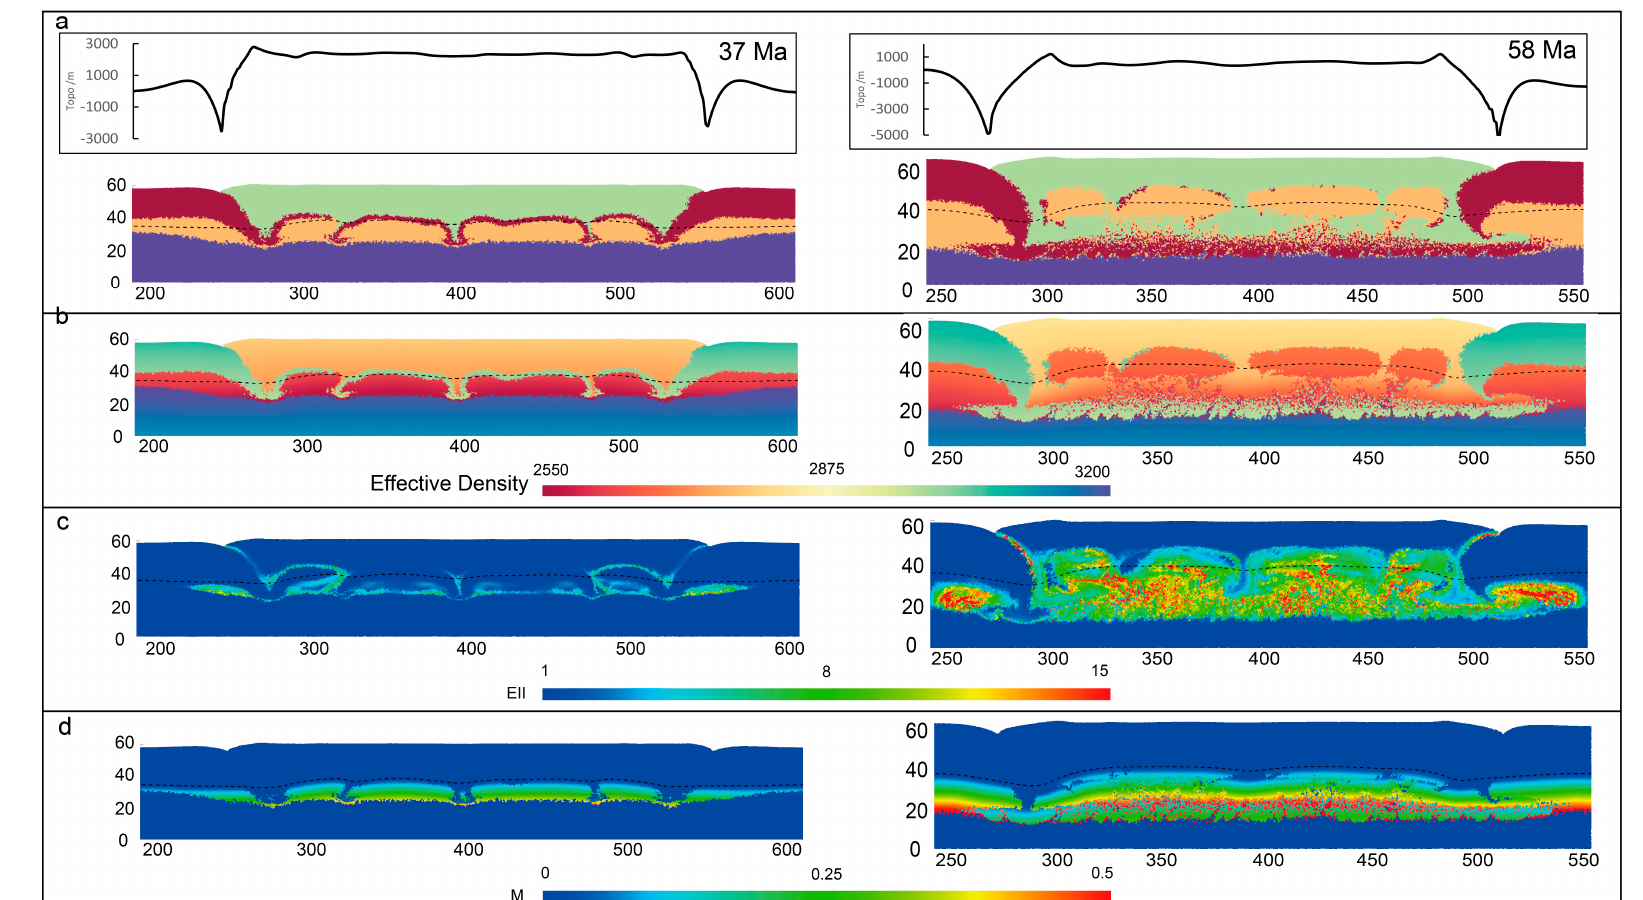
Figure 12. Model450, the width of sediment is set to 450 km. The solidus temperature of the lower crust is shown in dashed line. ( a ) At 37 Ma, buoyant lower crustal rocks form four crustal-scale folds. Moderate-high pressure volcano-sedimentary rocks are preserved in three-fold hinges. At 58 Ma, partially molten lower crustal rocks ascend into the weak sediment and form four diapirs with different sizes. ( b ) Effective density is calculated by Equations (5) and (6). ( c ) The accumulation ( EII ) of the second invariant of the strain rate ( ε II , s − 1 ) is employed to identify shear zones over time (calculated by EII = ∑ t Equations (2) and